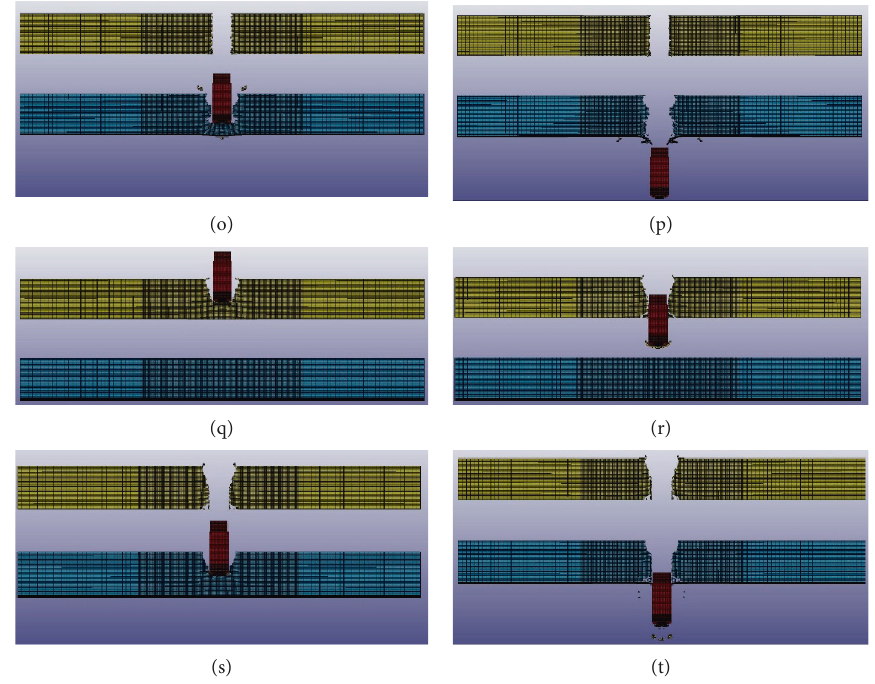
Figure 20: Perforation process of segmented targets with different steel liner layouts (1/2): (a) 140 μ s (3-0-0-0); (b) 340 μ s (3-0-0-0); (c) 540 μ s (3-0-0-0); (d) 820 μ s (3-0-0-0); (e) 80 μ s (2-0-0-1); (f) 340 μ s (2-0-0-1); (g) 540 μ s (2-0-0-1); (h) 740 μ s (2-0-0-1); (i) 100 μ s (1.5-0-0- 1.5); (j) 340 μ s (1.5-0-0-1.5); (k) 520 μ s (1.5-0-0-1.5); (l) 820 μ s (1.5-0-0-1.5). Perforation process of segmented targets with different steel liner layouts (2/2): (m) 100 μ s (1-0-0-2); (n) 320 μ s (1-0-0-2); (o) 540 μ s (1-0-0-2); (p) 840 μ s (1-0-0-2); (q) 100 μ s (0-0-0-3); (r) 300 μ s (0-0-0- 3); (s) 460 μ s (0-0-0-3); (t) 800 μ s